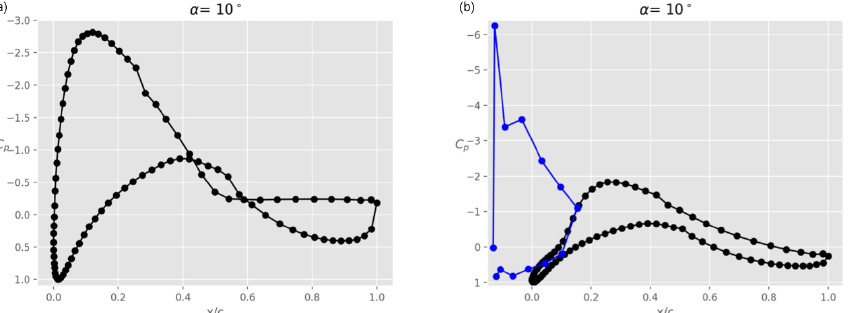
Figure 9. Pressure coefficient C p at α = 10 ◦ for a clean main airfoil (i.e. no tripping): main airfoil alone (a) and main airfoil with slat in case A (b) , where both the pressure distributions on the main airfoil (black) and slat (blue) are shown.